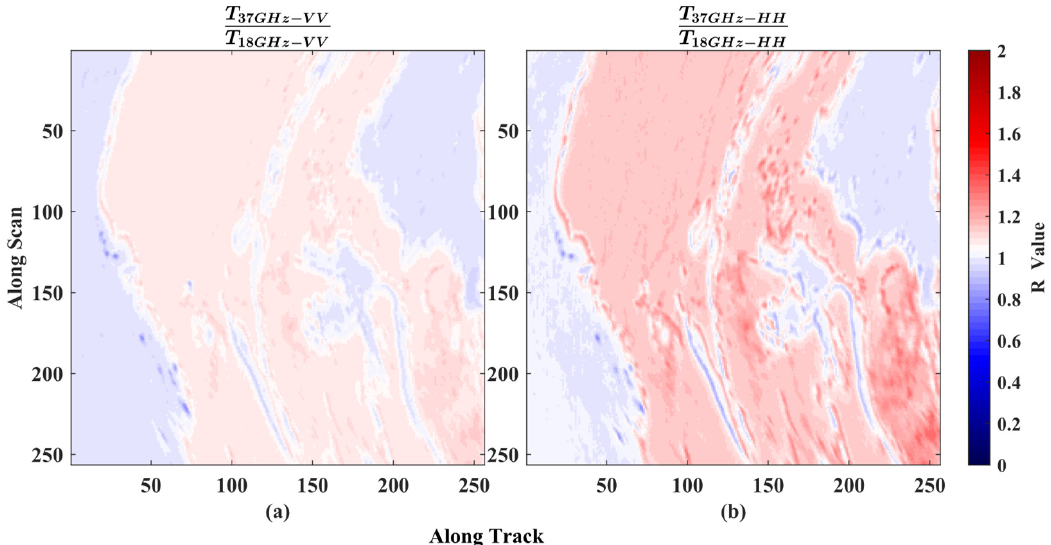
Figure 6. Value of R in actual MWRI scene with horizontal and vertical polarization. ( a ) Value of R for Vertical Polarization; ( b ) value of R for Horizontal Polarization.